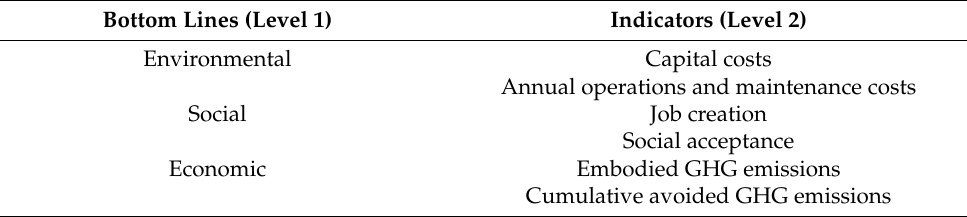
Table 1. A list of indicators for the triple bottom line